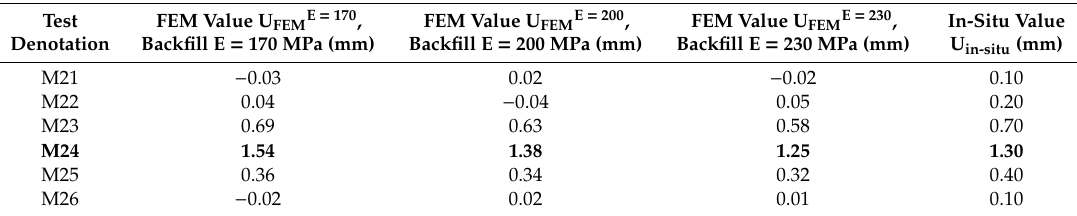
Table 4. Comparison of the in situ measured and estimated by means of FEM displacements in p4 / 4 measuring point during the moving load tests